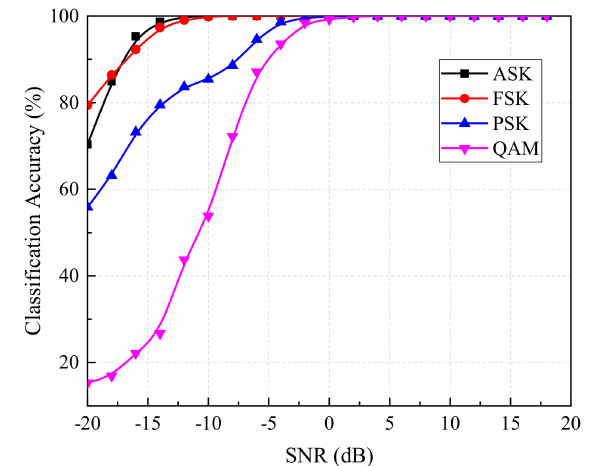
Figure 10. Curves about inter-class classification accuracy versus